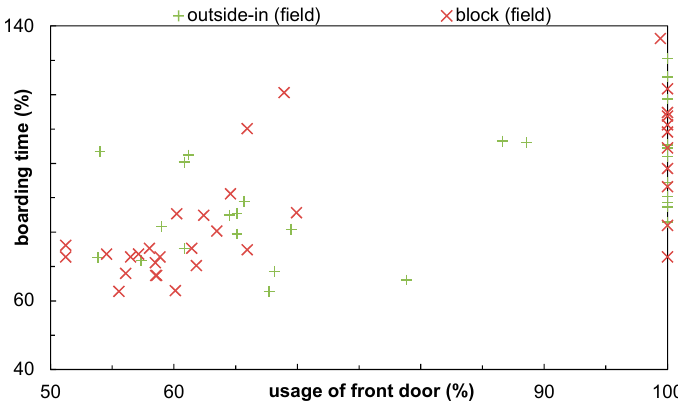
Figure 14. Usage of the front door at the field trial.